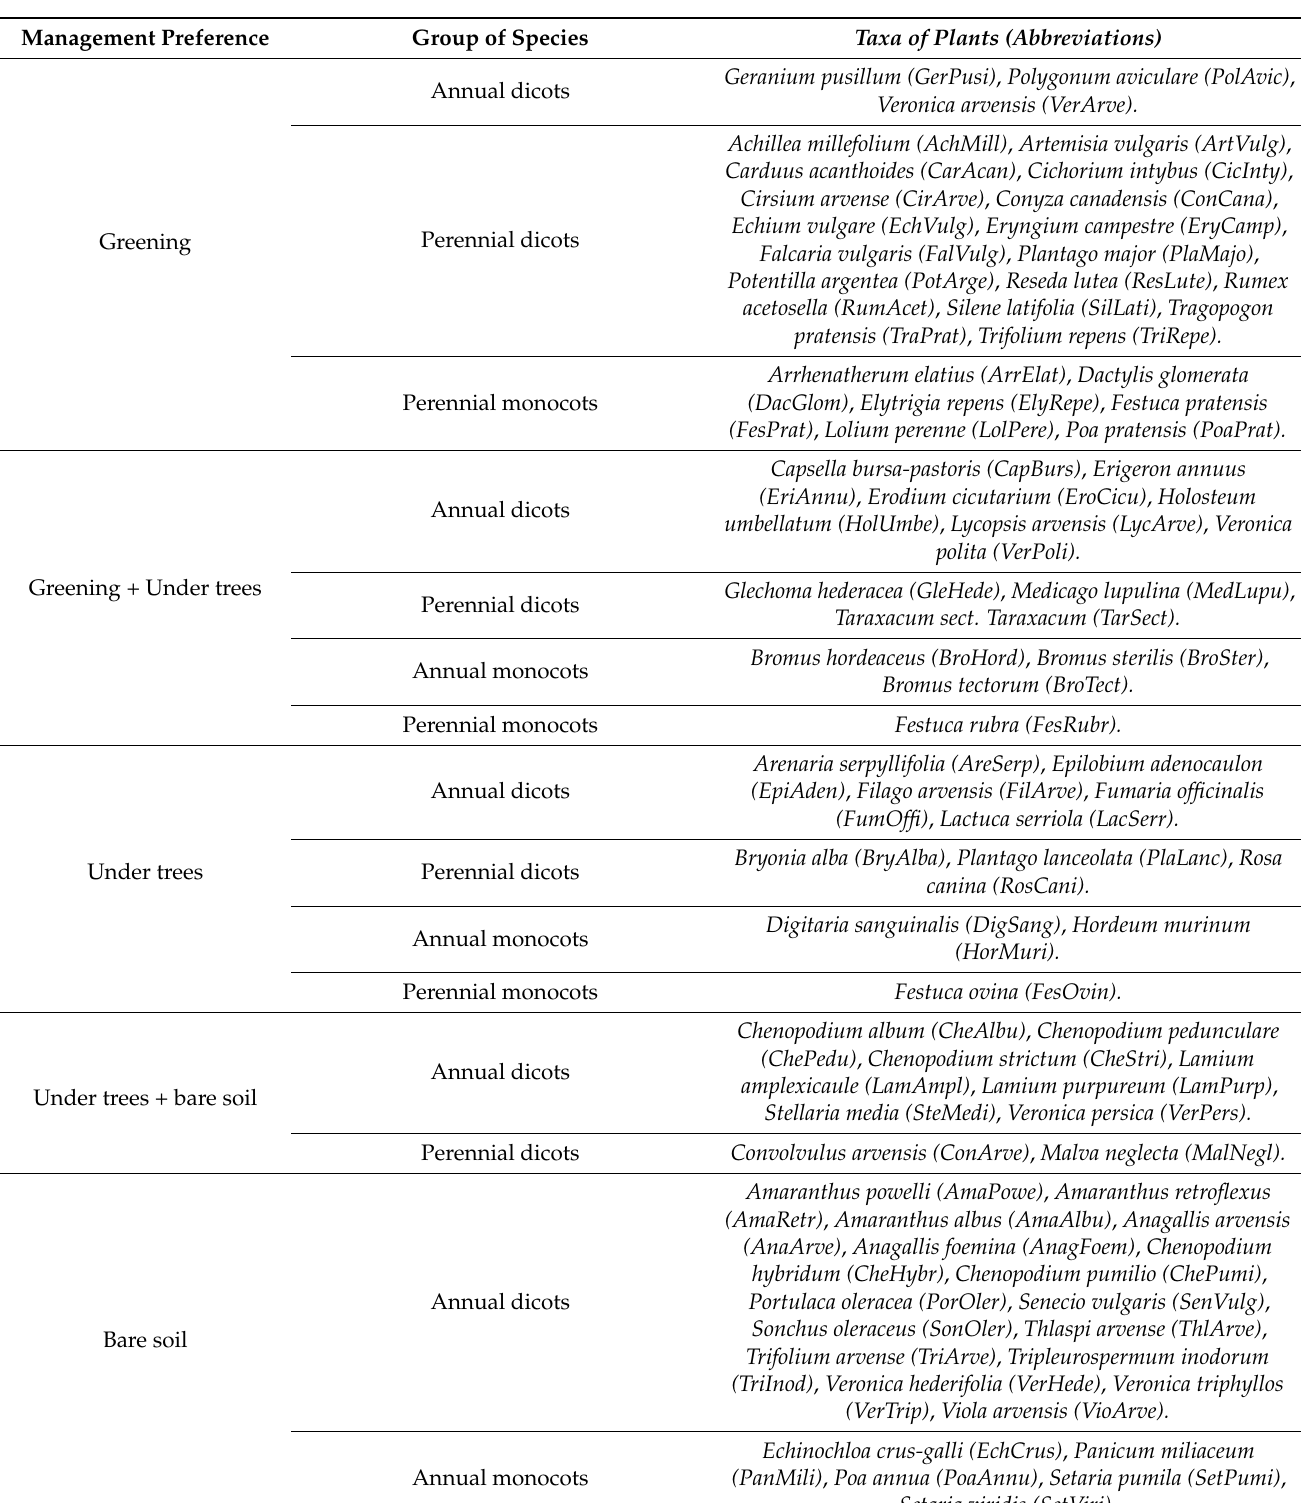
Table 1. Groups of plant species according to CCA